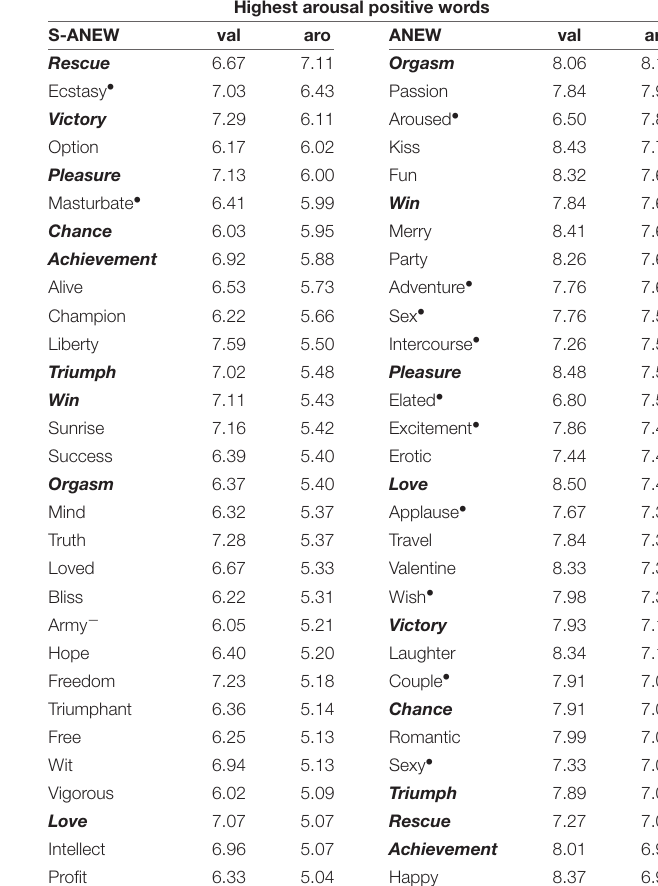
TABLE 4 | The thirty negative valence (left) and positive valence (right) highest arousal rated words. Highest arousal negative words Highest arousal positive